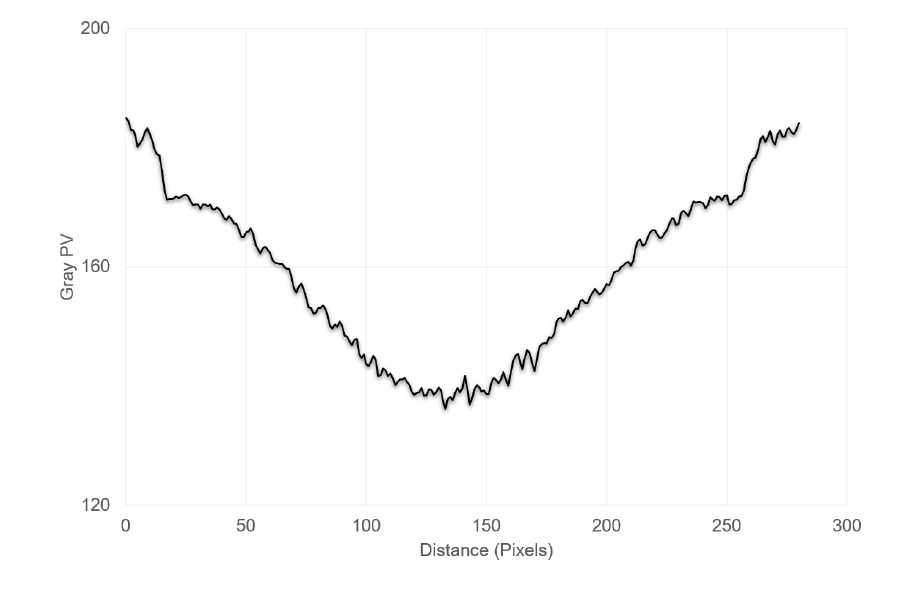
Figure 3. Typical two-dimensional dose distribution measured with RCFs. Adapted from Reference [86]. The gray PV is plotted as a function of the distance, expressed in pixels. It should be noted that in this scale 255 corresponds to the maximum light and 0 to no light